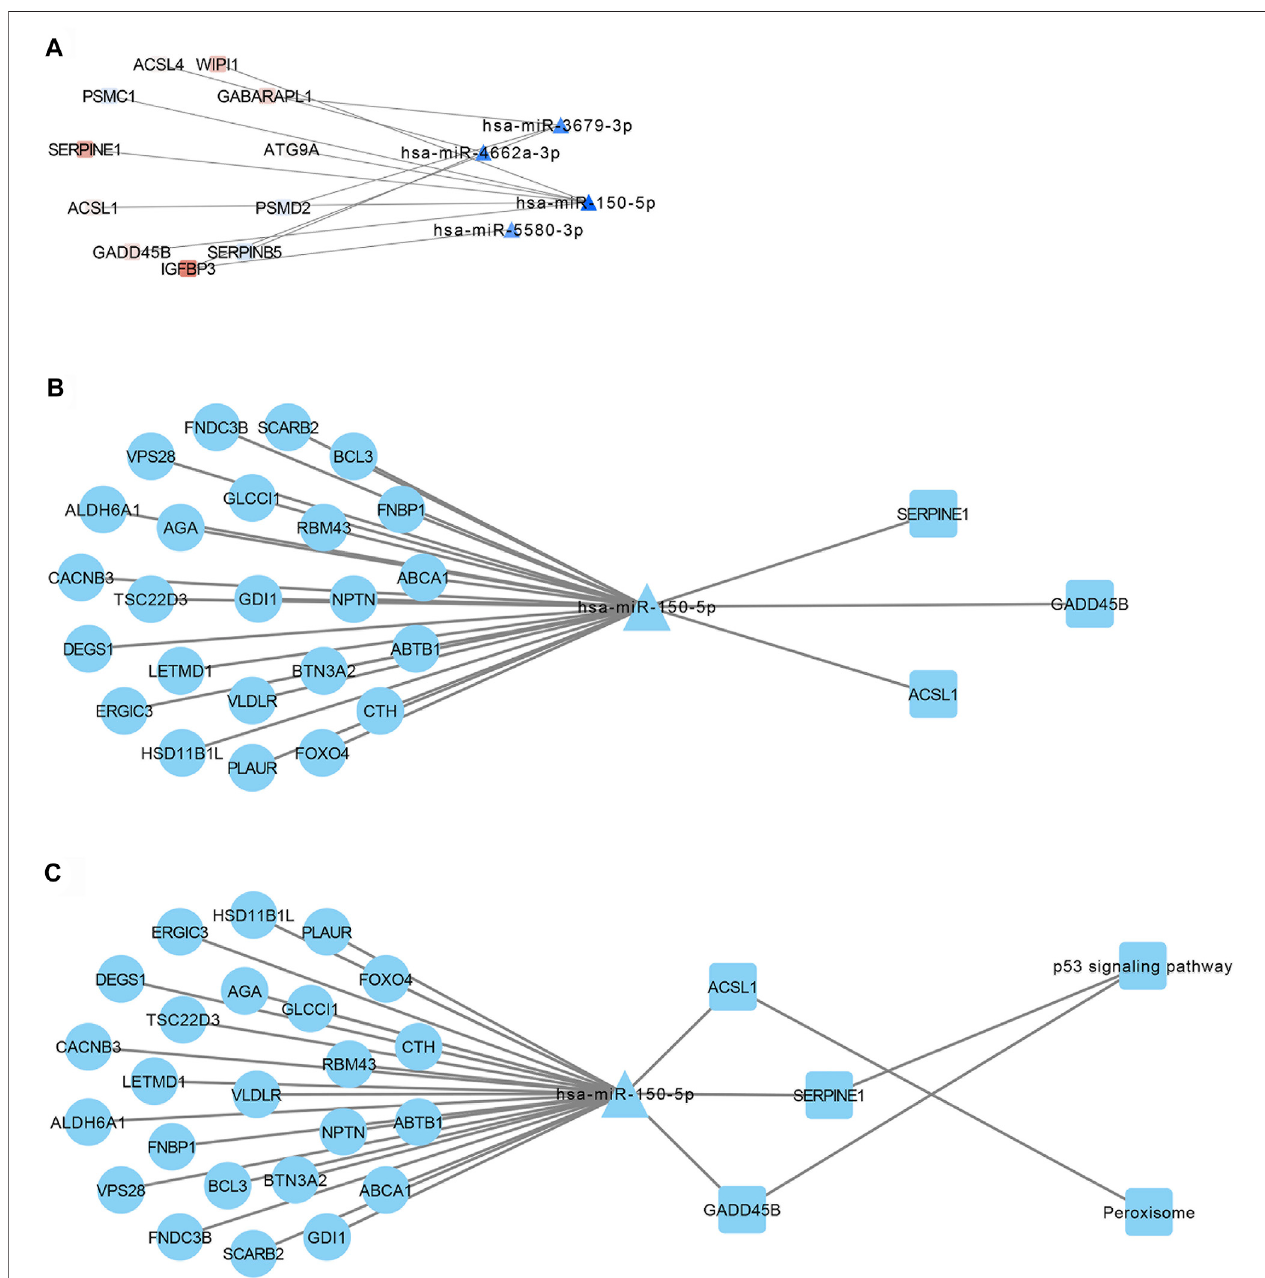
FIGURE5| TranscriptionalregulatorynetworkoflncRNAs,miRNAsandmRNAsinvolvedinNSCLCresistancetoEGFR-TKIs. (A) InteractionsbetweenmiRNAsandmRNAsinvolved insuchresistance. (B) Identi fi cationofceRNAsub-networks,based onthecriteriaR > 0.75and p < 0.01. (C) Combinationofthetranscriptionalregulatory network withKEGGpathways.